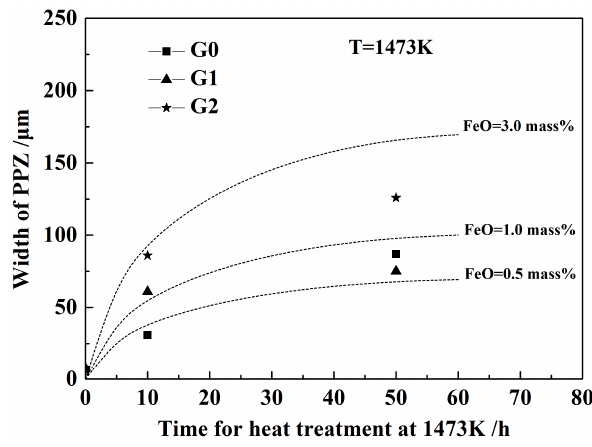
Figure 16. Change of PPZ width with heat treatment time and FeO content in diffusion couple G0, G1, and G2 before and after heat treatment in the experiment and calculation model.